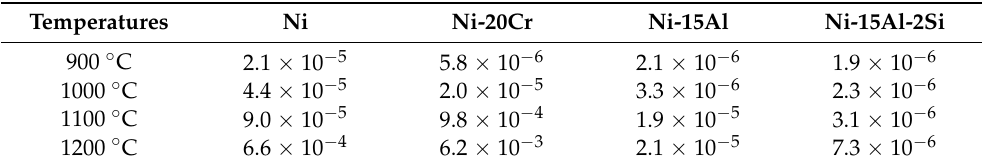
Table 3. Calculated k values [mg 2 /(cm 4 s 2 )] of Ni, Ni-20Cr, Ni-15Al, and Ni-15Al-2Si alloys at temperatures ranging from 900 ◦ C to 1200 ◦ C.